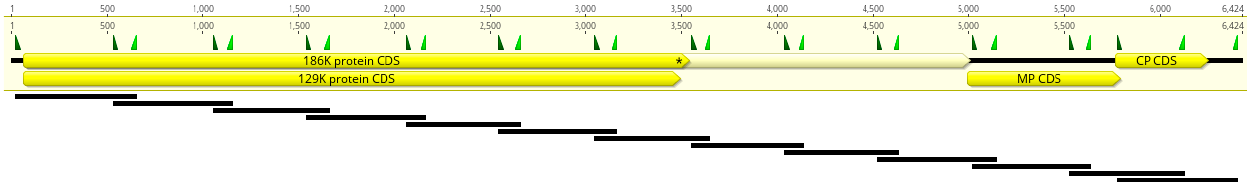
Figure 6. Diagram showing alignment of PCR amplicons (black lines) to the cucumber green mottle mosaic reference genome (GenBank Accessions No. NC_001801.1). Coding sequence regions for the 186K protein, 129K protein, movement protein and coat protein are shown. Multiplex primers are shown at predicted binding sites, left (forward) primers are dark green and right (reverse) primers are in light green. (Geneious version 2022.0 created by Biomatters. Available from https://www.geneious.com).